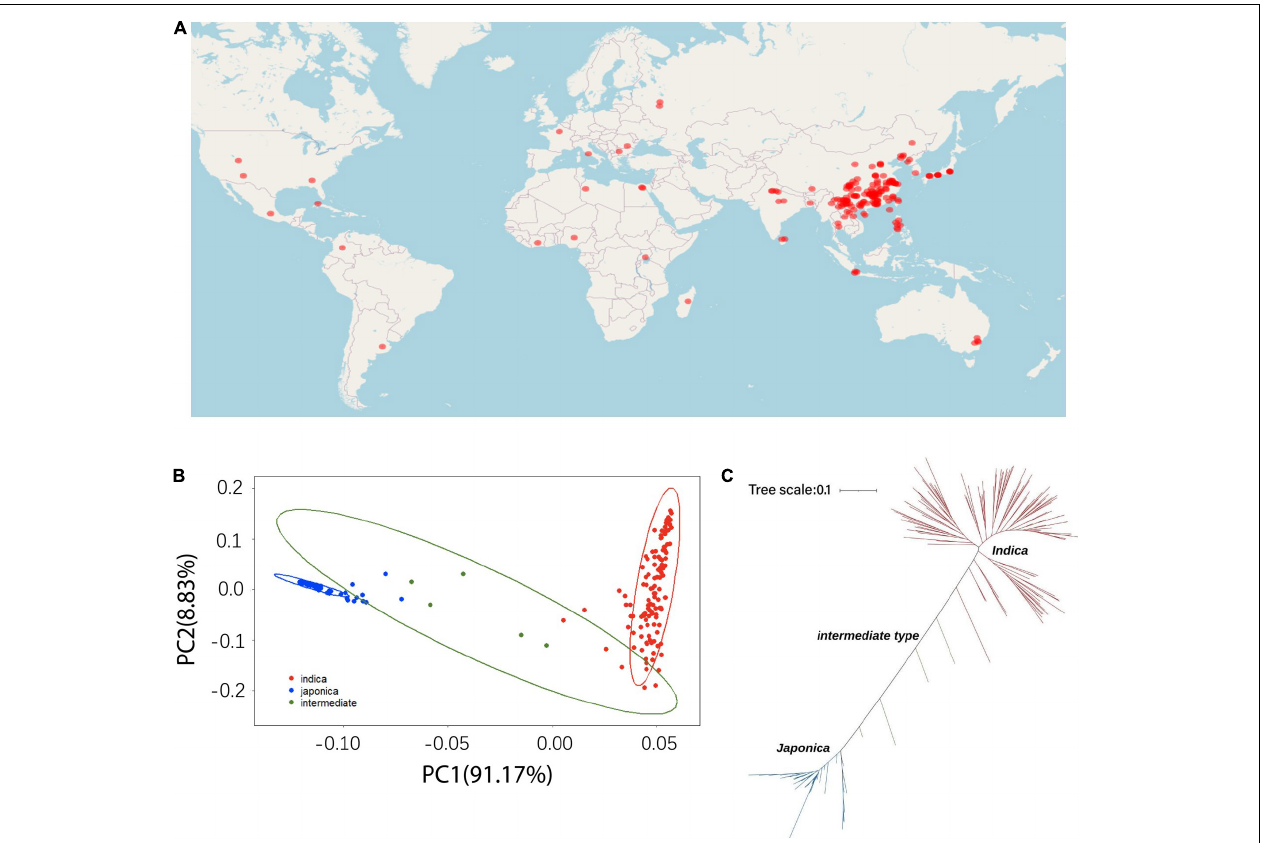
FIGURE 1 | The geographic distribution and population genetic structure across the 191 rice cultivated accessions. (A) Geographic distribution. (B) Principal component analysis. (C) Neighbor-joining tree of the 191 cultivated rice accessions.